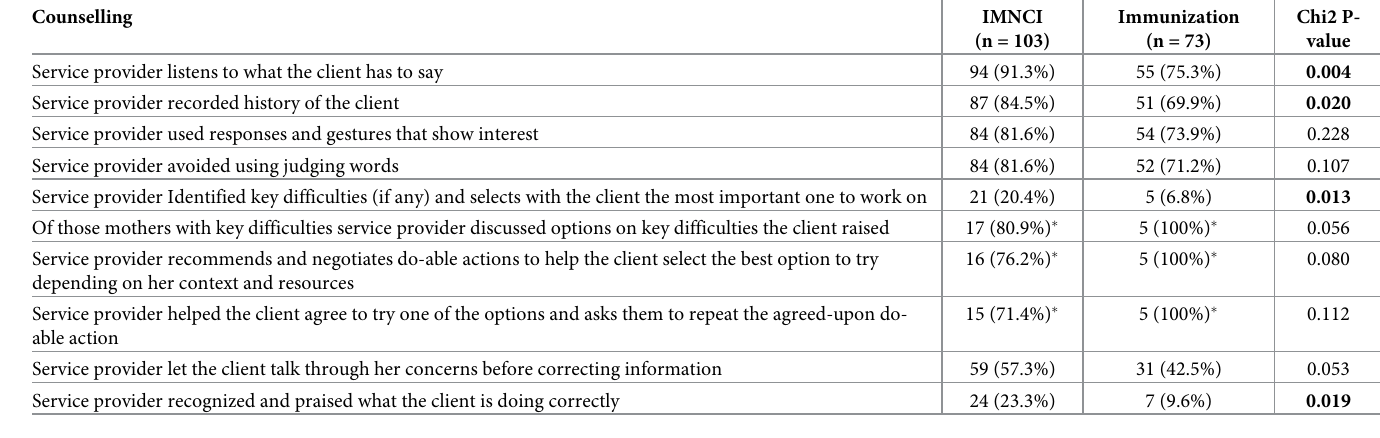
Table 9. Counselling skill of service providers during provision of counseling at IMNCI and immunization service points. Counselling